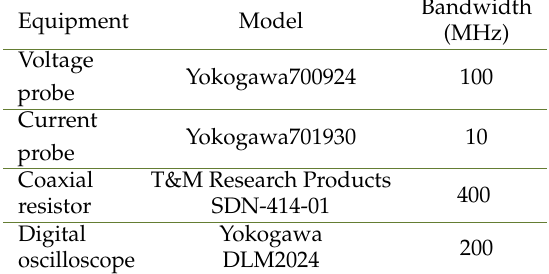
Fig. 3. Waveforms of probe calibration Table 2. Equipment for test